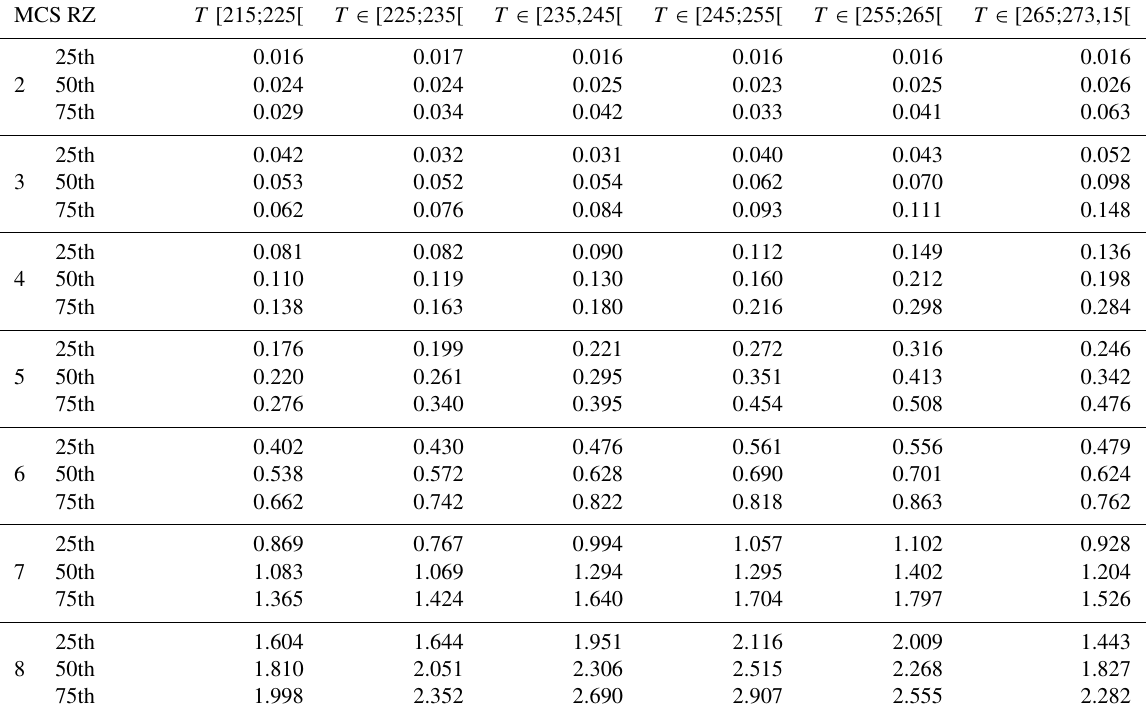
Table C2. Ice water content (IWC) in gm − 3 (Fig. 5).